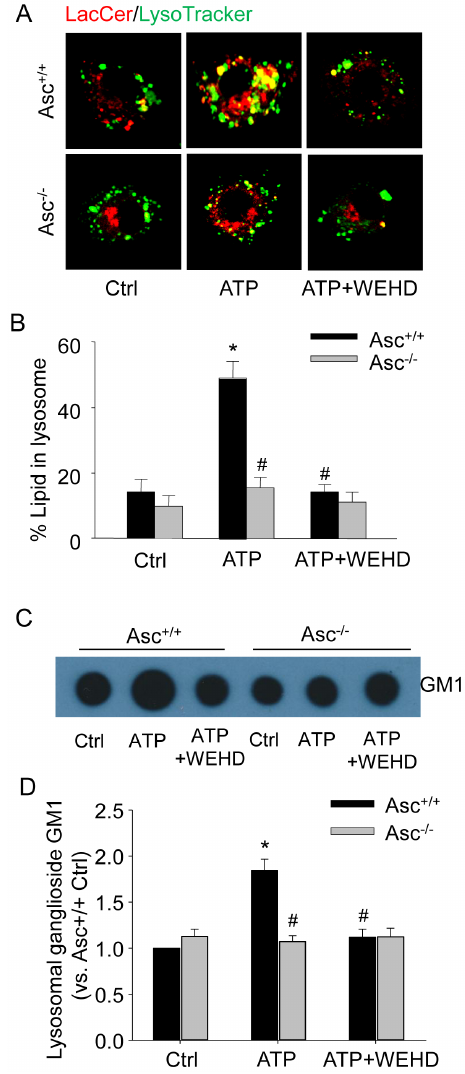
Figure 7. ATP-induced lipid trafficking in lysosomes was blocked in Asc 2 / 2 BMMs. Asc + / + and Asc 2 / 2 BMMs were primed with low dose of LPS (1 ng/ml) for 3 h and treated with ATP (2.5 mM, 16 h) in the absence or presence of caspase-1 inhibitor WEHD (0.15 m g/ ml). (A) BMMs were incubated with BSA-conjugated BODIPY FL-C 5 - lactosylceramide (LacCer) and lipid trafficking was tested by following LacCer trafficking. Representative confocal fluorescent images show the co-localization between LacCer (red color) and Lysotracker (green color). An increase in the yellow color in overlay images indicates increased LacCer trafficking to the lysosomes. (B) Quantified and summarized data showing the percent of lipid in lysosomes. (C) The ganglioside GM1 levels in isolated lysosomes from BMMs were determined by dot blot analysis. Represent dot blot image shows the ganglioside GM1 level in isolate lysosome homogenates as detected by cholera toxin-conjugated HRP. (D) Summarized analysis of ganglioside GM1 in lysosomes. * P , 0.05 vs . untreated Asc + / + control group; # P , 0.05 vs . Asc + / + ATP group (n=6).